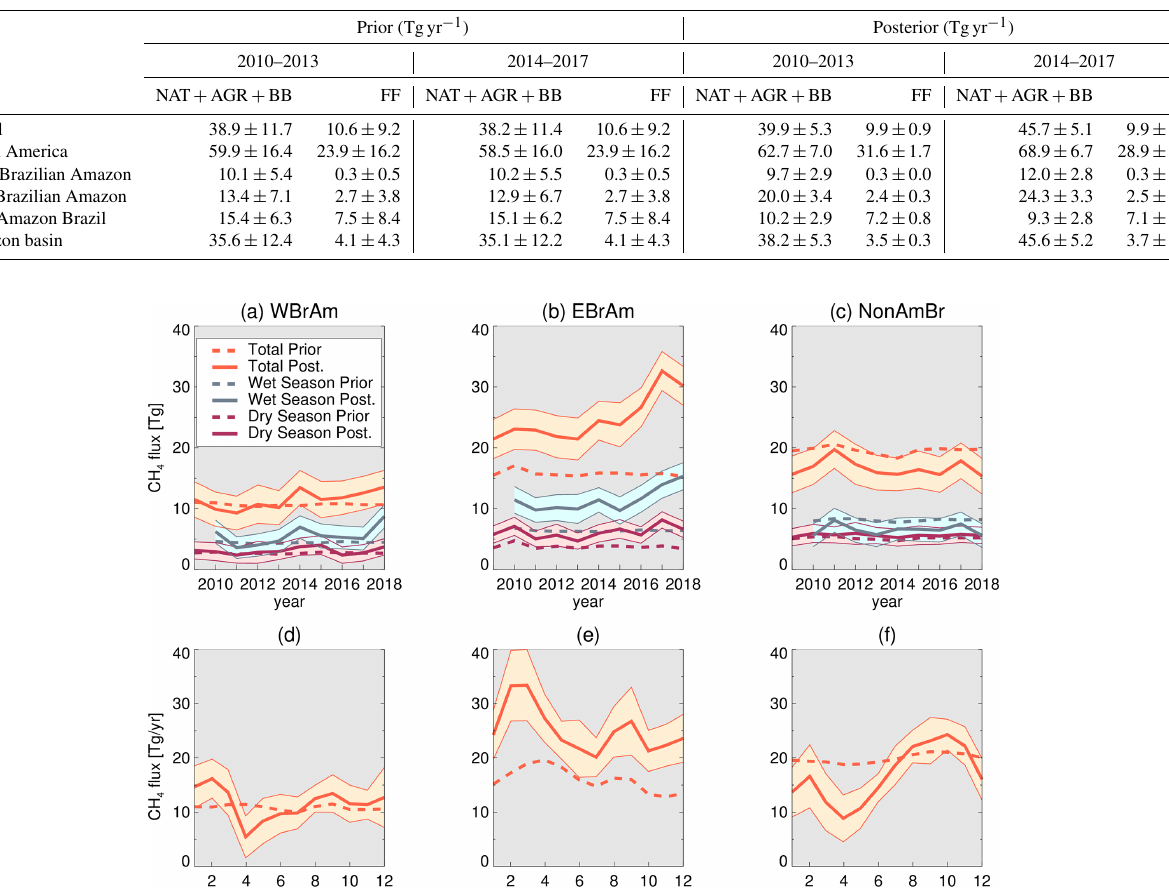
Table 1. Prior and posterior emissions of CH 4 for Brazil and other subregions of South America (2010–2017). Units are Tgyr − 1 .